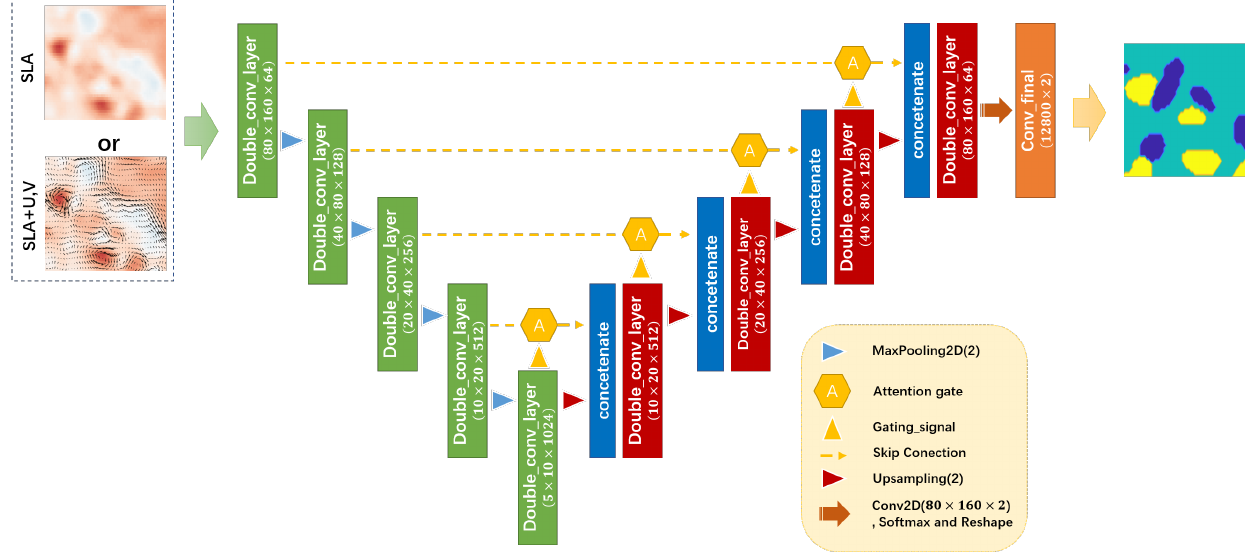
Figure 1. Schematic diagram of the Attention Resnet U-Network